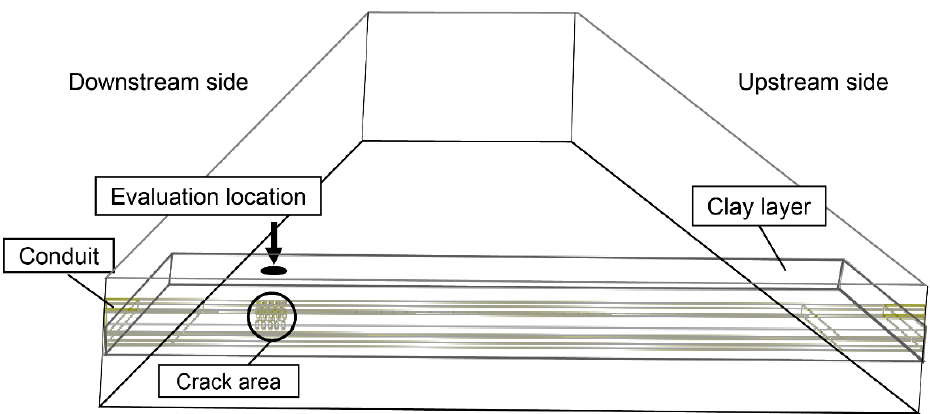
Figure 9. Location of hydraulic-gradient evaluation.